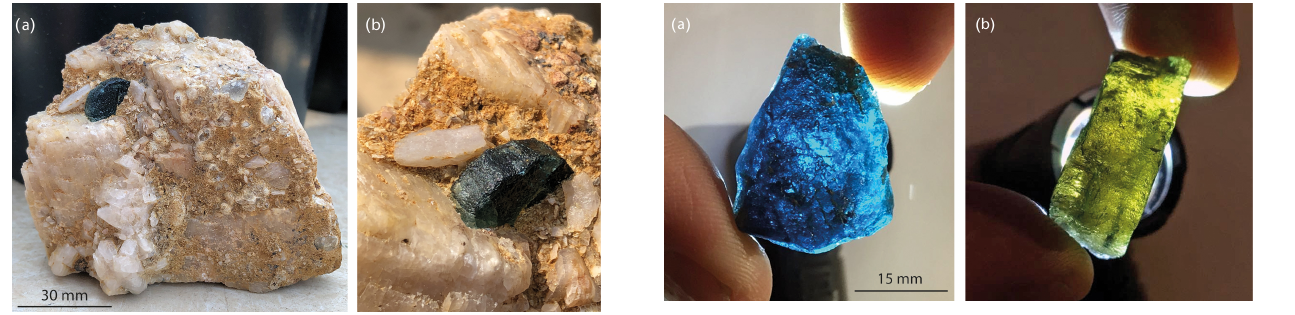
Figure 2. Images showing the strong dichroism of laurentthoma- site crystals. Under white light, crystals are deep cobalt blue along [0001] and yellow-green perpendicular to